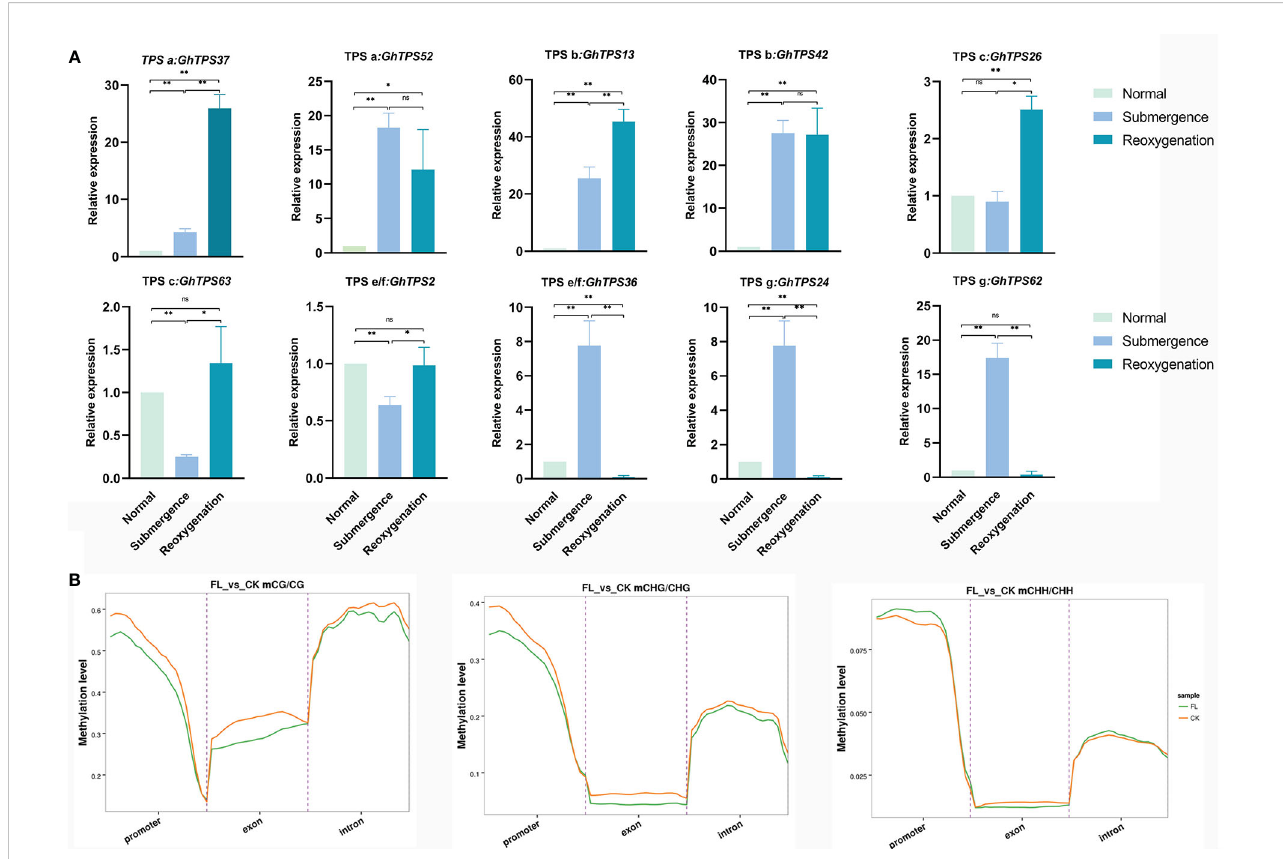
FIGURE 10 Levels of methylation in the CG/CHG/CHH sequences and expression levels of GhTPSs. (A) The expression levels of 10 GhTPSs under submergence and reoxygenation stresses. Error bars represent SD in biological replicates. (B) Distribution of methylation levels in functional region. Different colors represent groups. ns, p>0.05, *0.05>p>0.01,